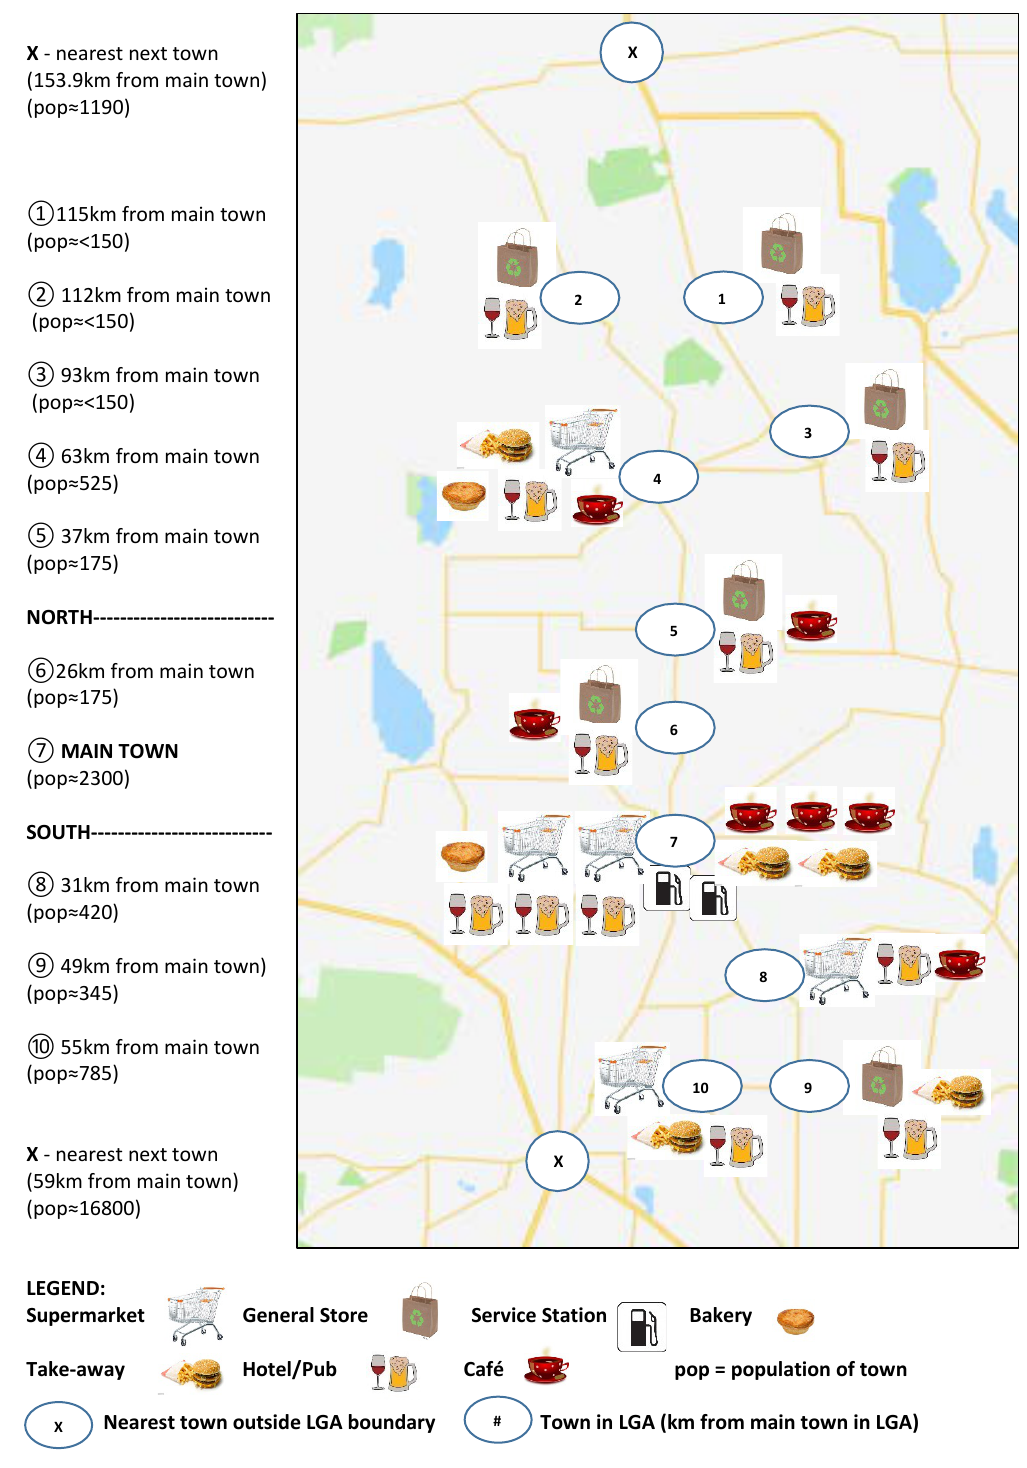
Figure 1. Distribution of food retail outlets across ten towns within the Local Government Area indicating type of outlet and distance (km) of towns from the main town (https://www.google.com/